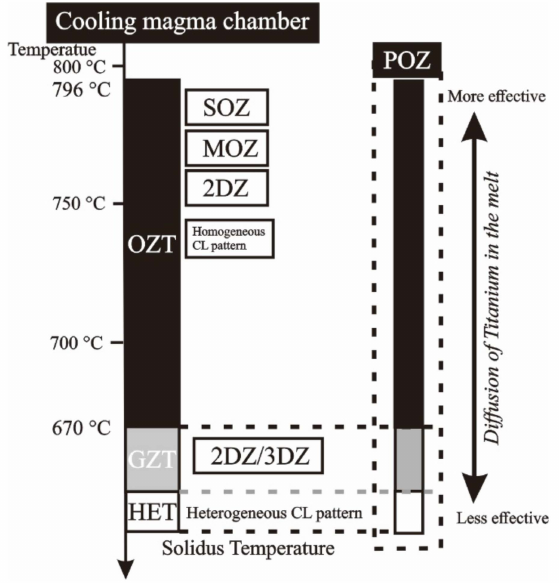
Figure 2. Demonstration of the cooling magma chamber history: SOZ and MOZ are formed at higher temperatures than homogeneous and heterogeneous CL (modified from